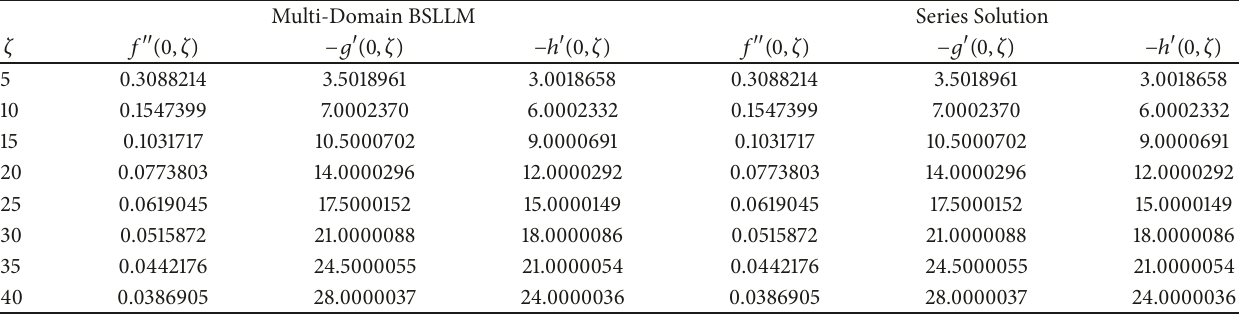
Table 2: Comparison of the multidomain solution and the series solution for 𝑓 󸀠󸀠 (0,𝜁) , −𝑔 󸀠 (0,𝜁) , and −ℎ 󸀠 (0,𝜁) : 𝑛 = 𝑤 = 1/2 , 𝑃𝑟 = 0.7 , 𝑆𝑐 = 0.6 , and 𝑧 = 40 .